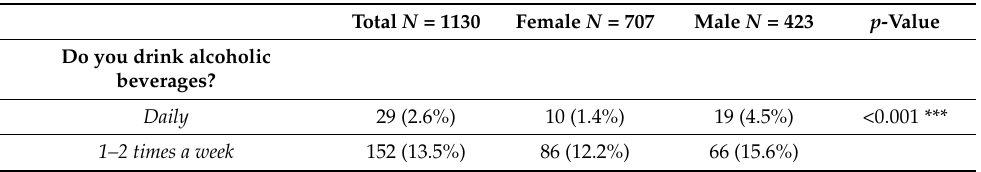
Table 4. Eating habits before and during the pandemic period of the university population and stratification by